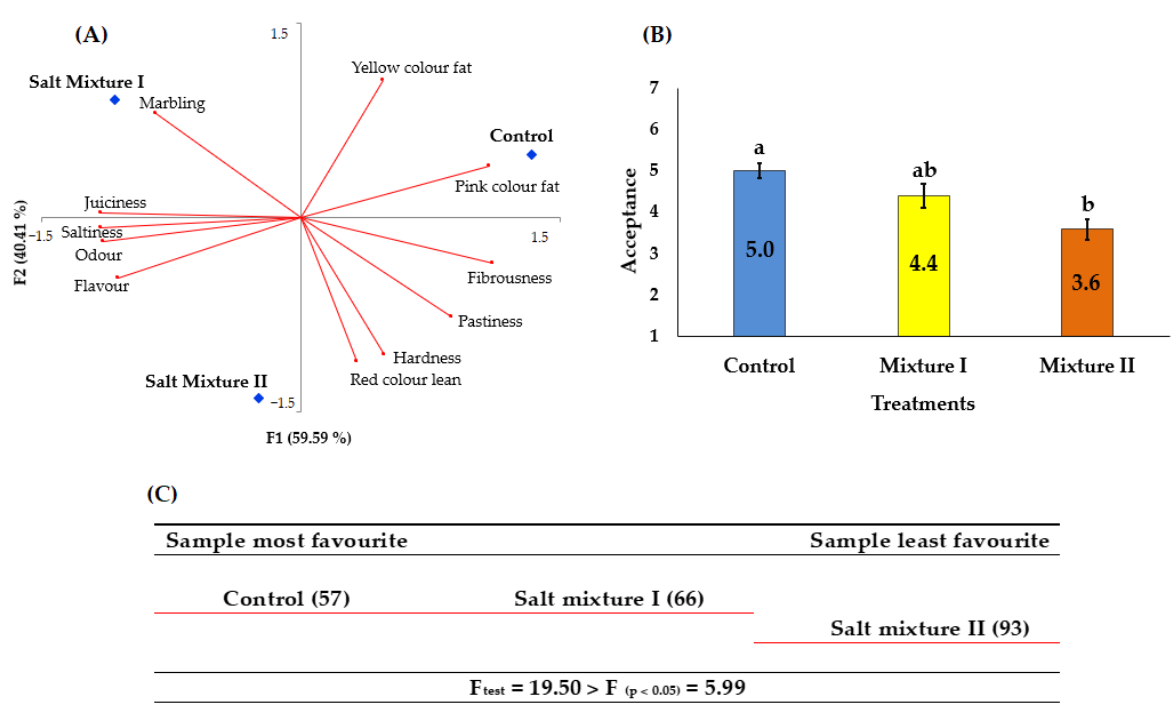
Figure 2. Sensorial profile ( A ), Overall acceptance ( B ), and Preference values and least significant difference (LSD) ( C ) of dry-cured deer cecina elaborated with three different treatments (Control: 100% NaCl; Salt mixture I: 30% NaCl and 70% KCl; Salt mixture II: 30% NaCl, 50% KCl, 15% CaCl 2 and 5% MgCl 2 ). a,b Mean values ± standard error (corresponding to the same parameter) followed by a different letter differ significantly ( p < 0.05; Tukey’s test). Preference test and LSD results: samples in the same row does not differ significantly ( p > 0.05) and samples in different rows differ significantly ( p ≤ 0.05). Numbers in brackets are Σ score.